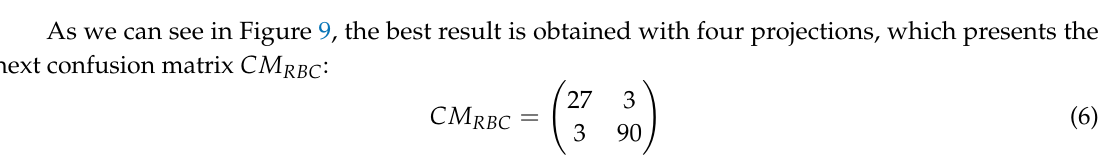
Figure 9. Recognition rate according to RBC